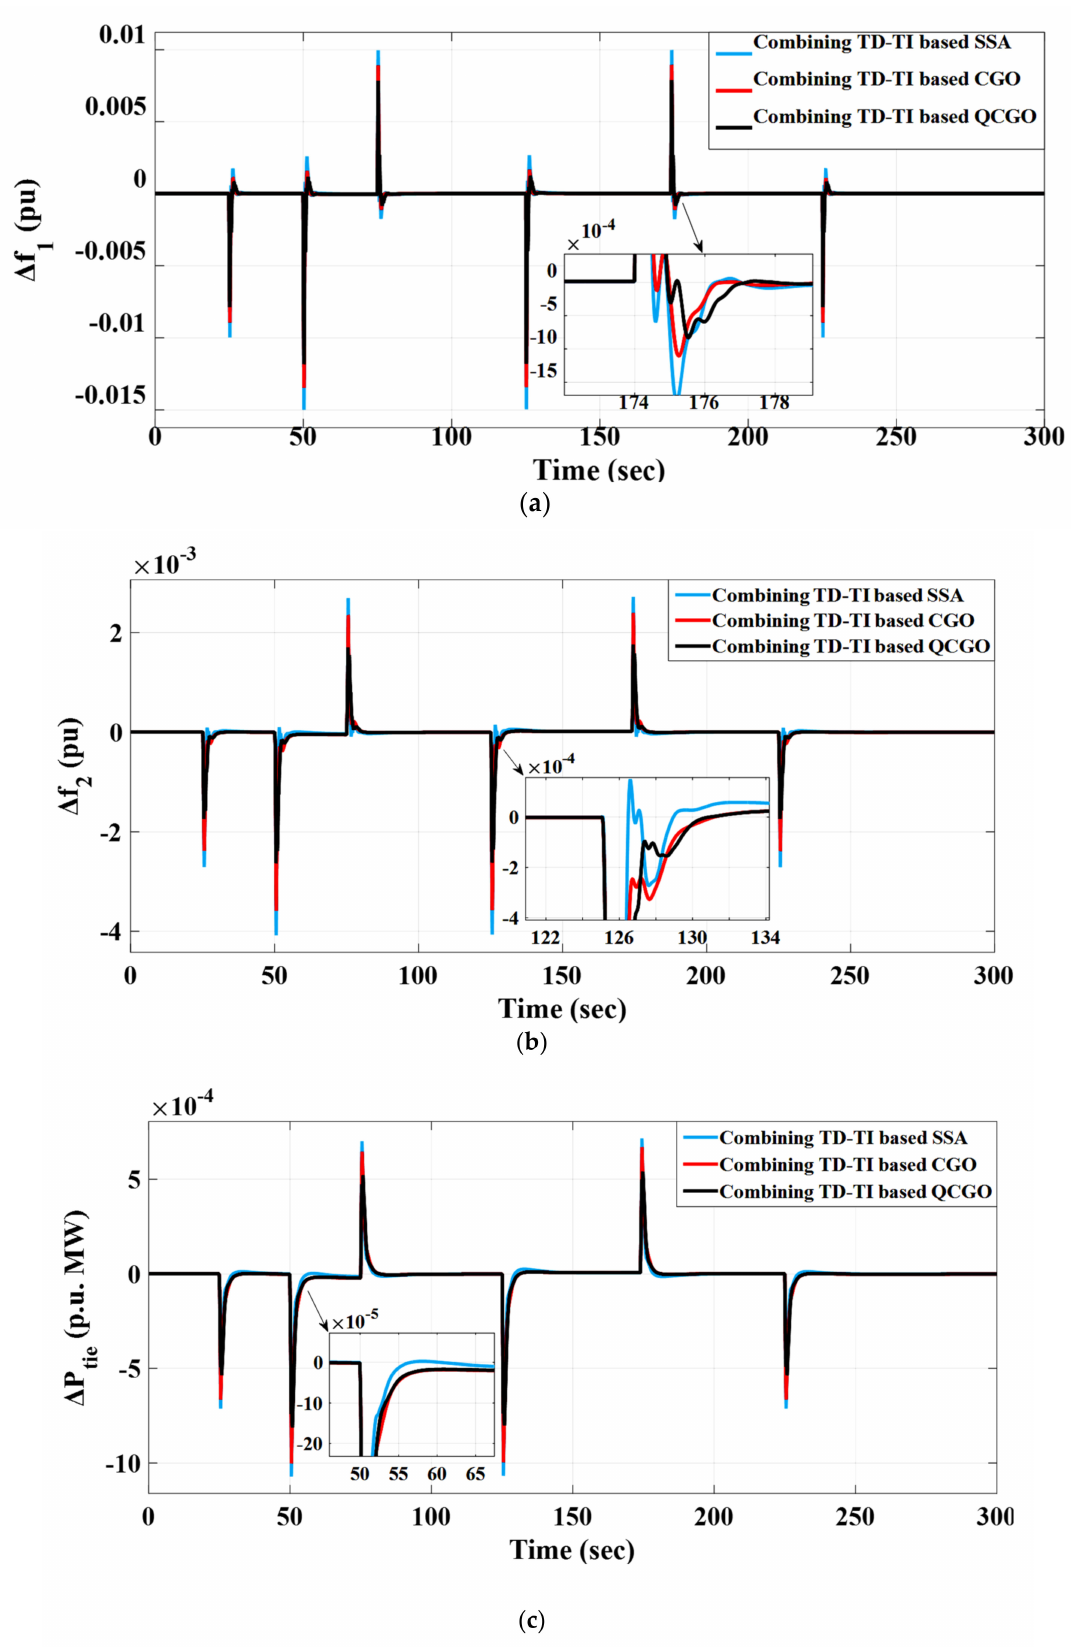
Figure 20. Dynamic power grid responses in case A.3: ( a ) ∆ f